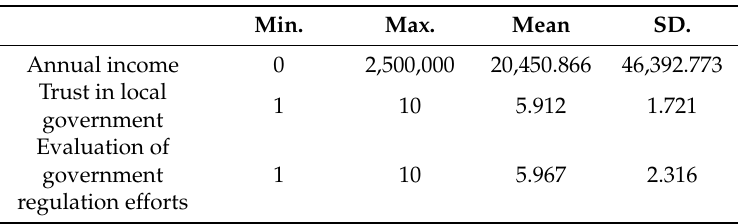
Table 2. Descriptive statistics of variables.